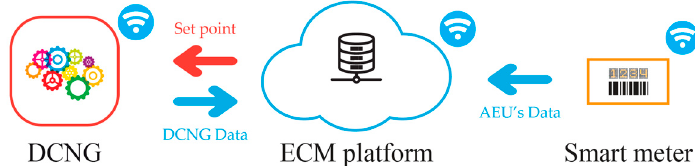
Figure 7. Communication